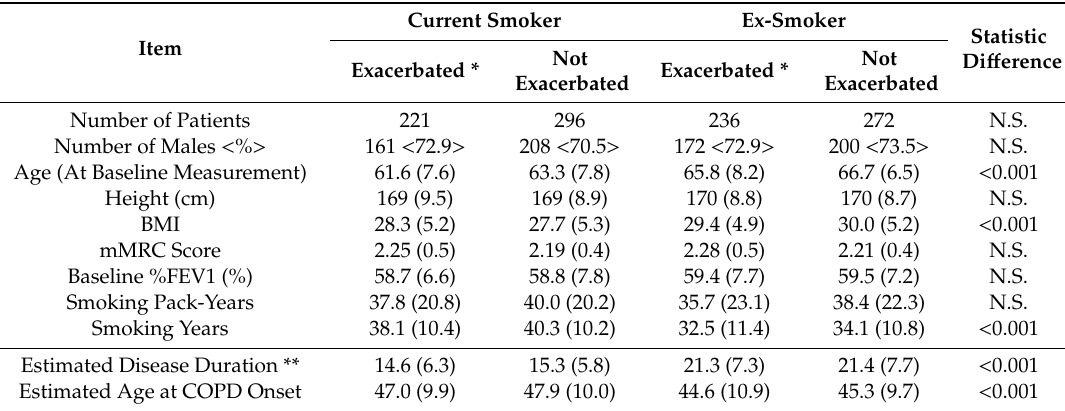
Table 4. Characteristics of patients in sub-group classified by adopted